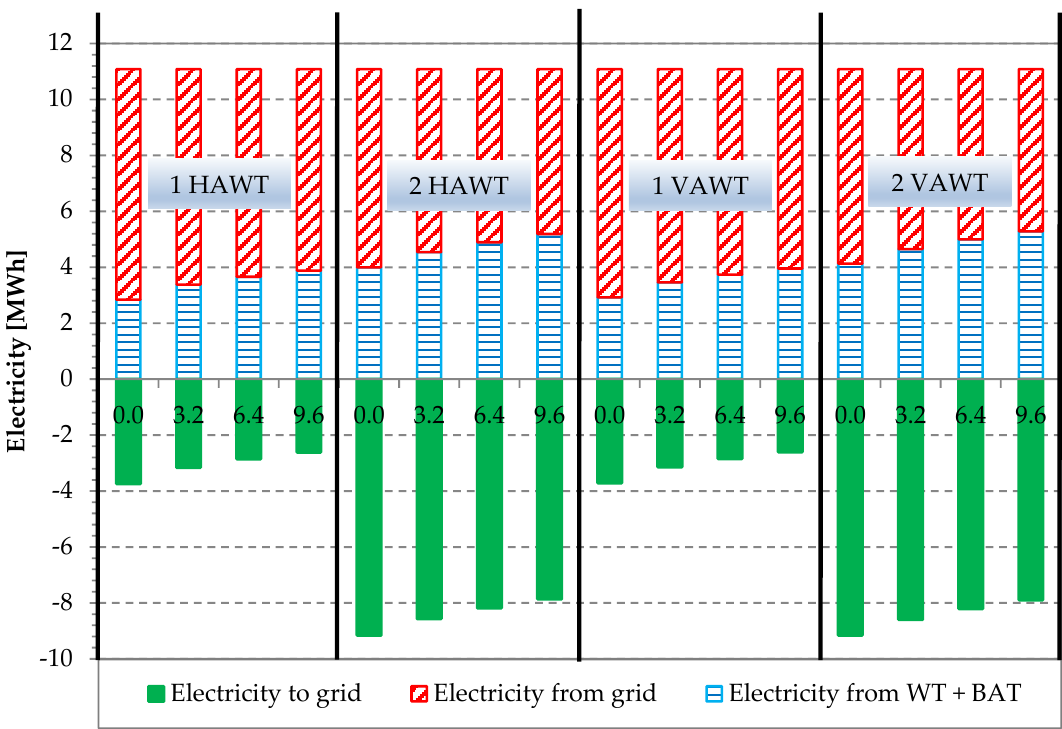
Figure 11. Electricity distribution for Cagliari as a function of WT configuration and battery storage capacity.